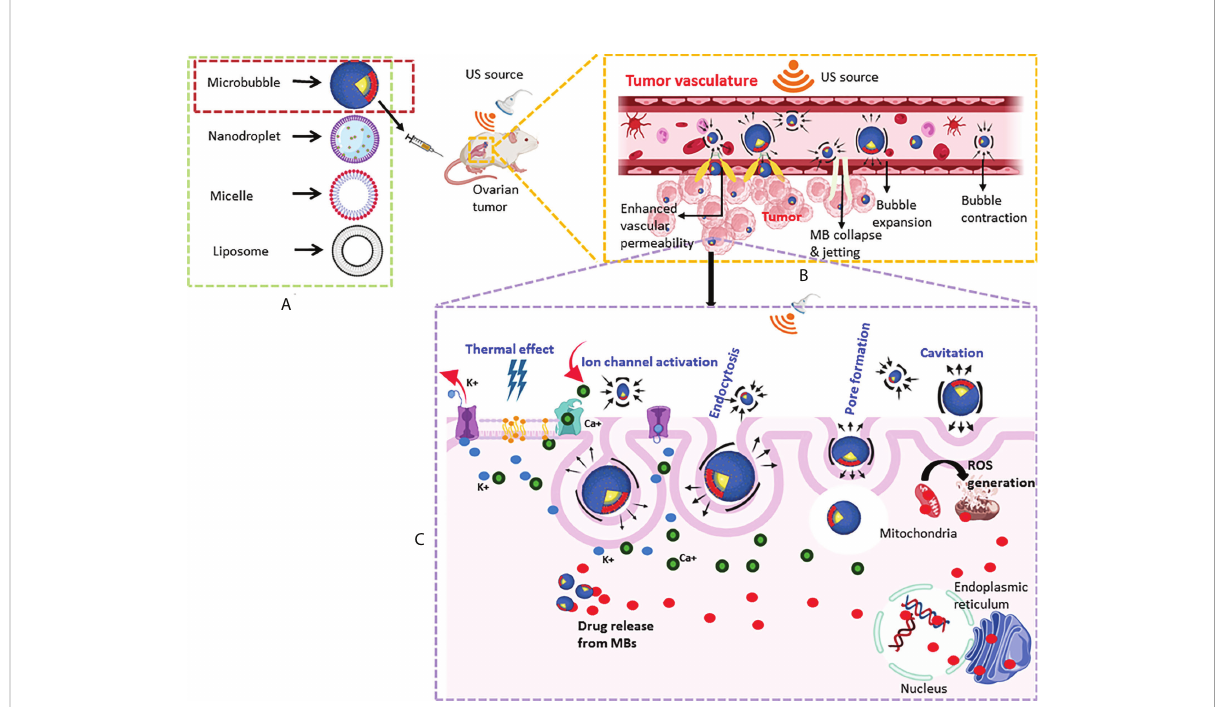
FIGURE 1 Schematic of US-mediated drug delivery system targeting ovarian tumors. (A) Simpli fi ed diagrammatic representation of major US-mediated drug delivery systems discussed in the review are shown (refer to table 1 for their salient features). (B) An example of the delivery of therapeutics to the tumor site by MBs using a US-based technique in a murine model of ovarian cancer. Circulating MBs are exposed to sonication using a focused US transducer to induce cavitation. Tumor endothelial cells become more permeable to the drug-carrying vehicles due to mechanical disruption caused by cavitation. (C) US-mediated changes (shown in blue) including increased membrane fl uidity by thermal effect, ion channel activation, pore formation, and endocytosis promote uptake of MBs by the cancer cells. Cavitation bubbles also cause ROS generation causing killing of the ovarian tumor cells.